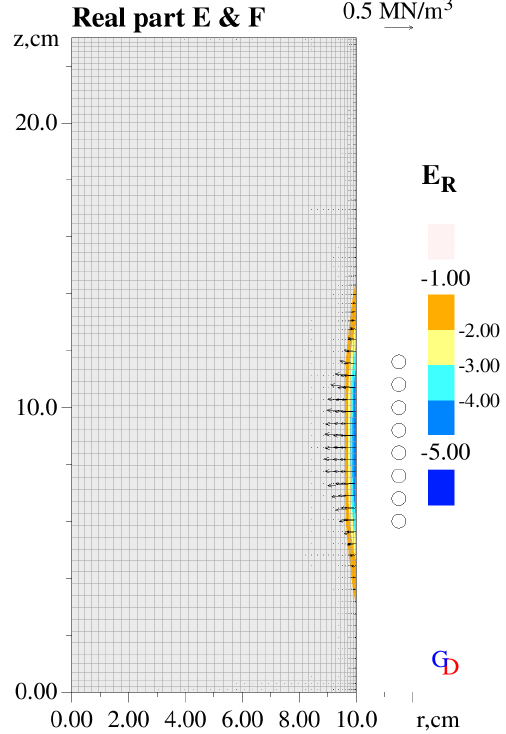
Figure 1. Mesh over liquid metal, computed electric field [V/m], and mean Lorentz force. The non-conducting vessel wall is not included in the mesh and not needed for the computation. The circles indicate the positions of the turns of the induction coil.